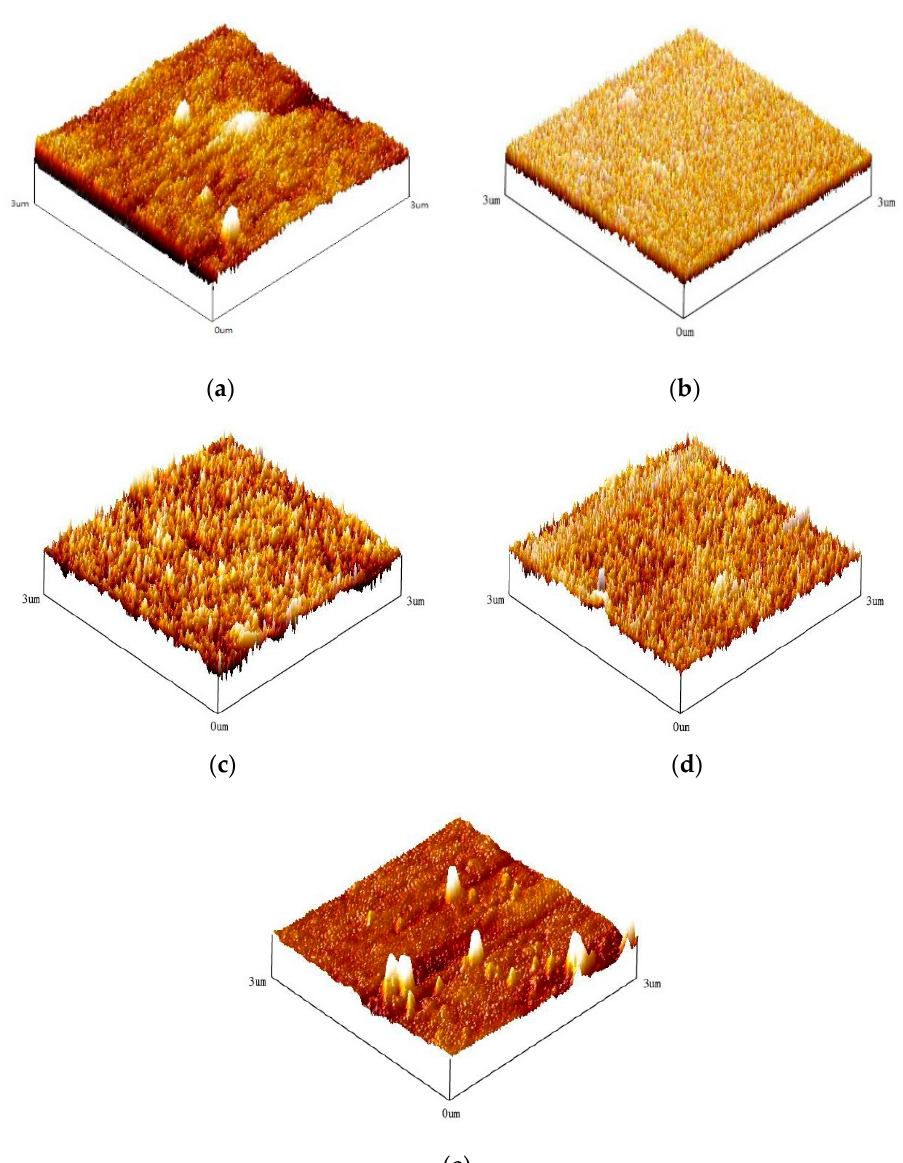
Figure 5. Atomic force microscopy (AFM) images of as-deposited and annealed Ti:SnO 2 films: ( a ) as-deposited, ( b ) annealed at 200 °C, ( c ) annealed at 300 °C, ( d ) annealed at 400 °C, and ( e ) annealed at 500 °C.